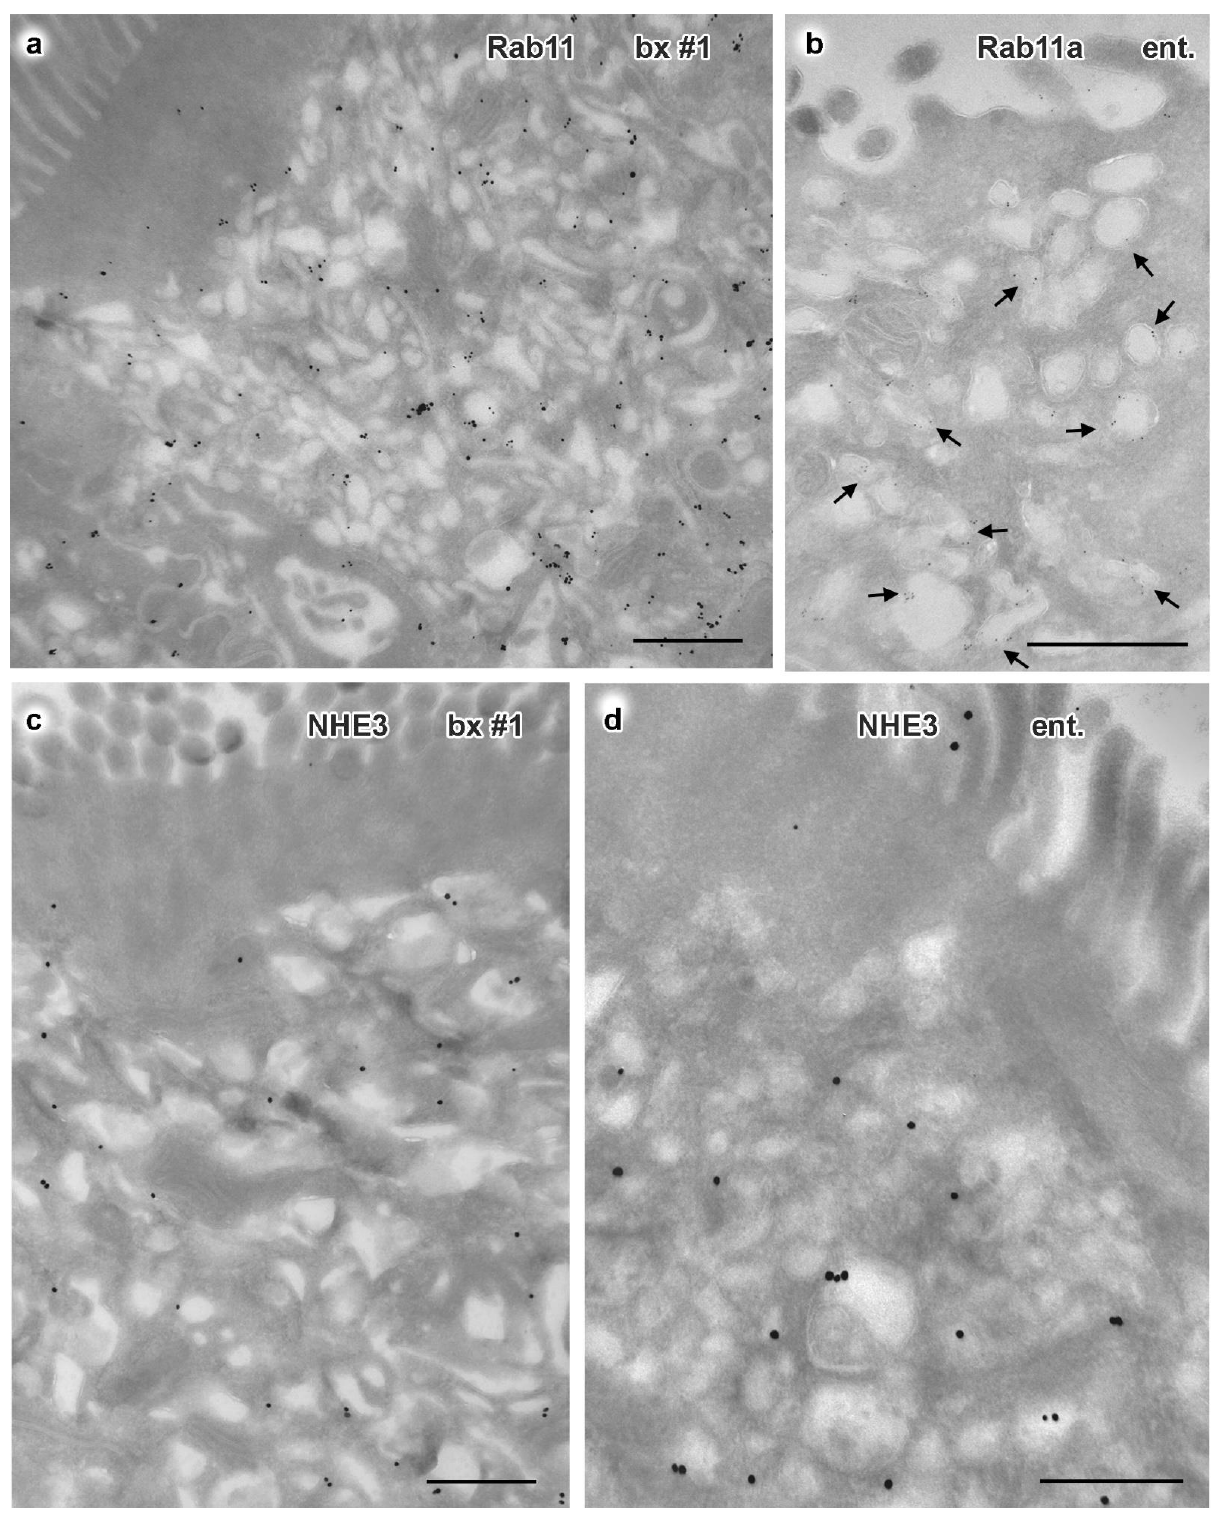
Figure 3. Immuno-gold EM of cryo-sections from formaldehyde-fixed duodenal biopsy and enteroid samples from MYO5B-PFIC patient #1. Corresponding mislocalization patterns of apical markers to aberrant subapical RE are evident in biopsy #1 ( a , c ) and enteroid ( b , d ); all scale bars = 500 nm. ( a ) Rab11 in biopsy visualized by 1.4nm Nanogold plus silver enhancement. ( b ) Rab11a in enteroid visualized by 5nm colloidal gold (arrows). ( c ) NHE3 in biopsy (enhanced Nanogold), ( d ) NHE3 in enteroid (enhanced